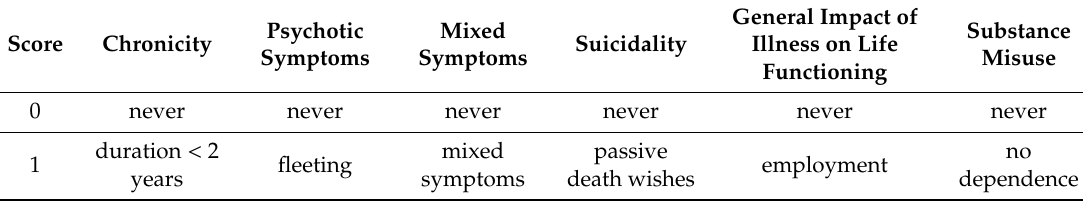
Table 1. Scoring of diagnostic interview for genetic studies according to clinical